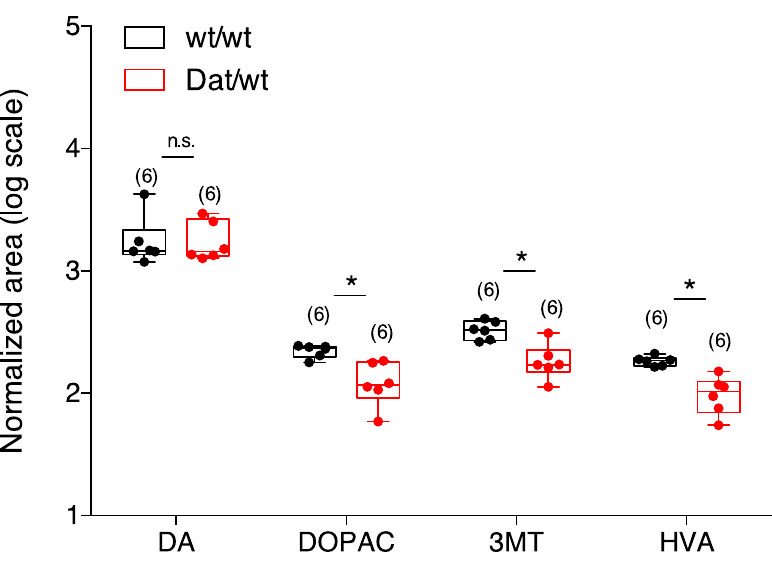
Figure 3. Levels of neurotransmitters in the striatum. The level of dopamine was the same in both Dnmt3a2/3L Dat / wt and Dnmt3a2/3L wt / wt animals. The levels of DOPAC, 3MT, HVA were lower in Dnmt3a2/3L Dat / wt animals. Abbreviations: DA: dopamine; 3MT: 3-methoxytyramine (extracellular metabolite); DOPAC: 3,4-dihydroxyphenyl acetic acid; HVA: homovanillic acid. Values are reported as the mean ± SEM. * p < 0.05. Student t -test has been used for comparison